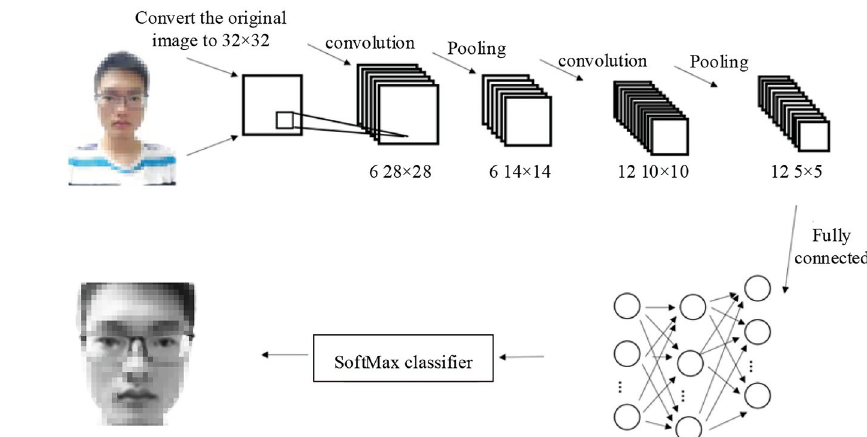
Figure 4. The CNN-based face recognition